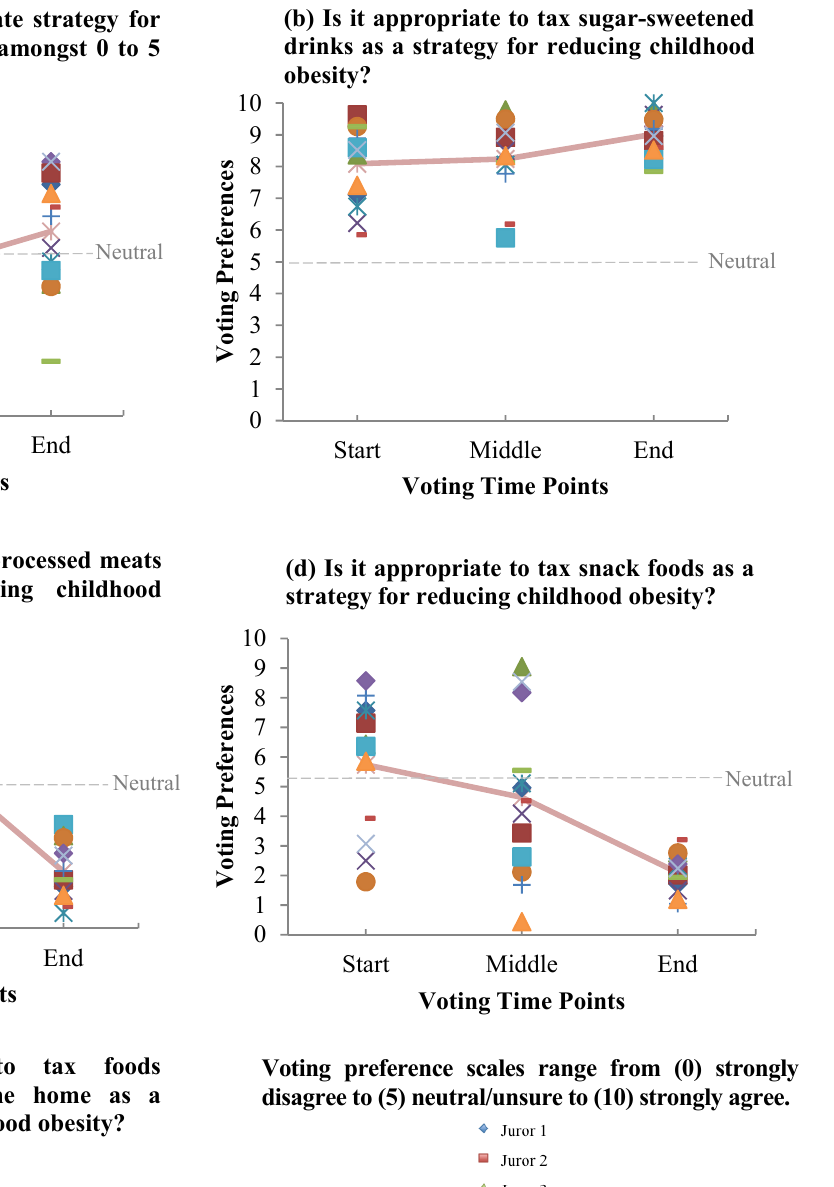
Voting preference scales range from (0) strongly disagree to (5) neutral/unsure to (10) strongly